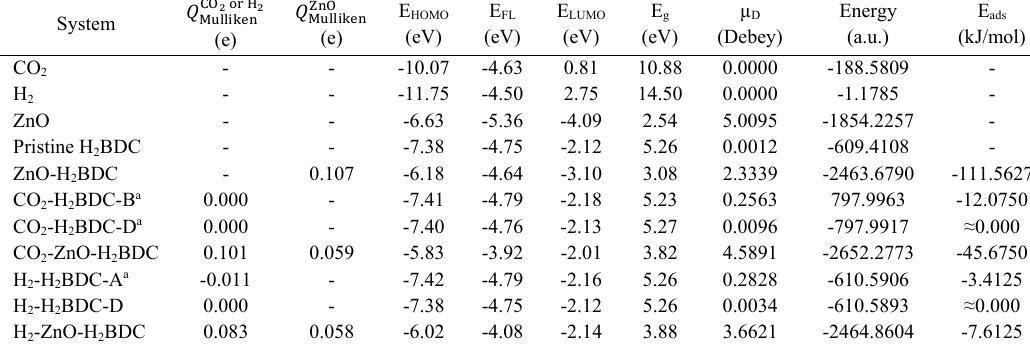
a Site A, B, and D in Fig. 2